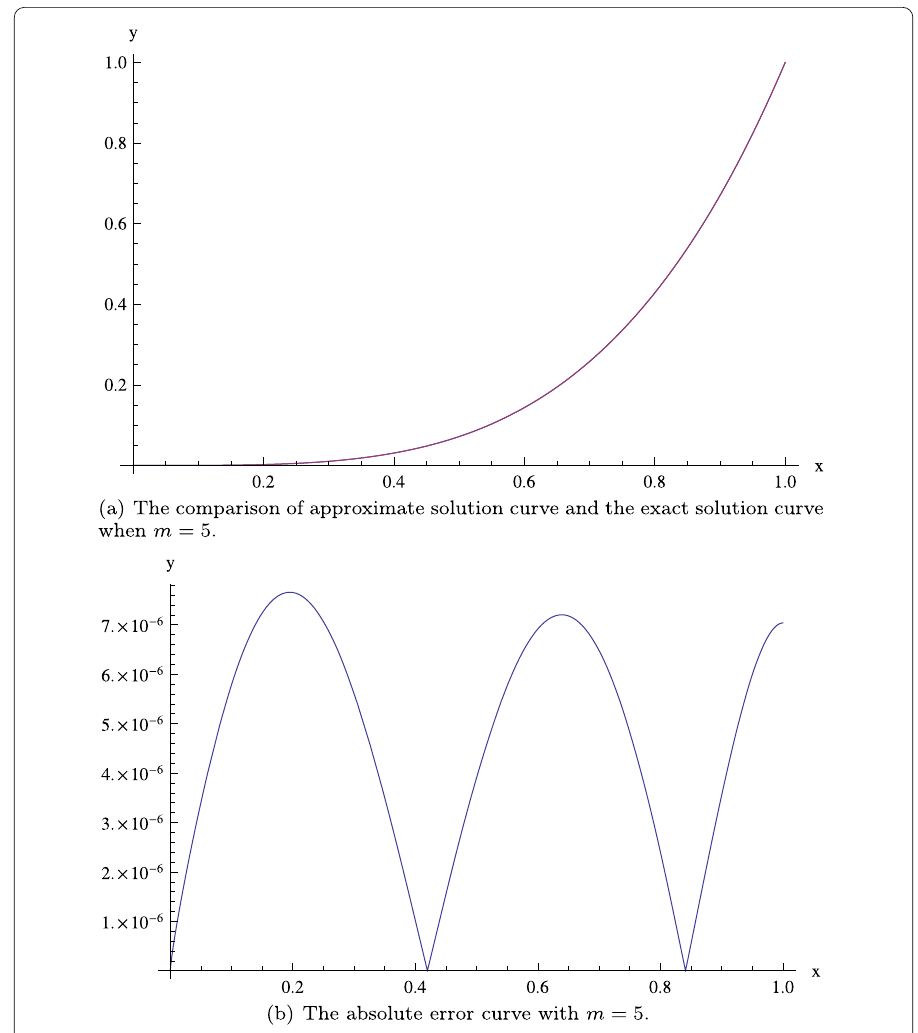
Figure 1 The comparison of the approximate solution and the exact solution when m =